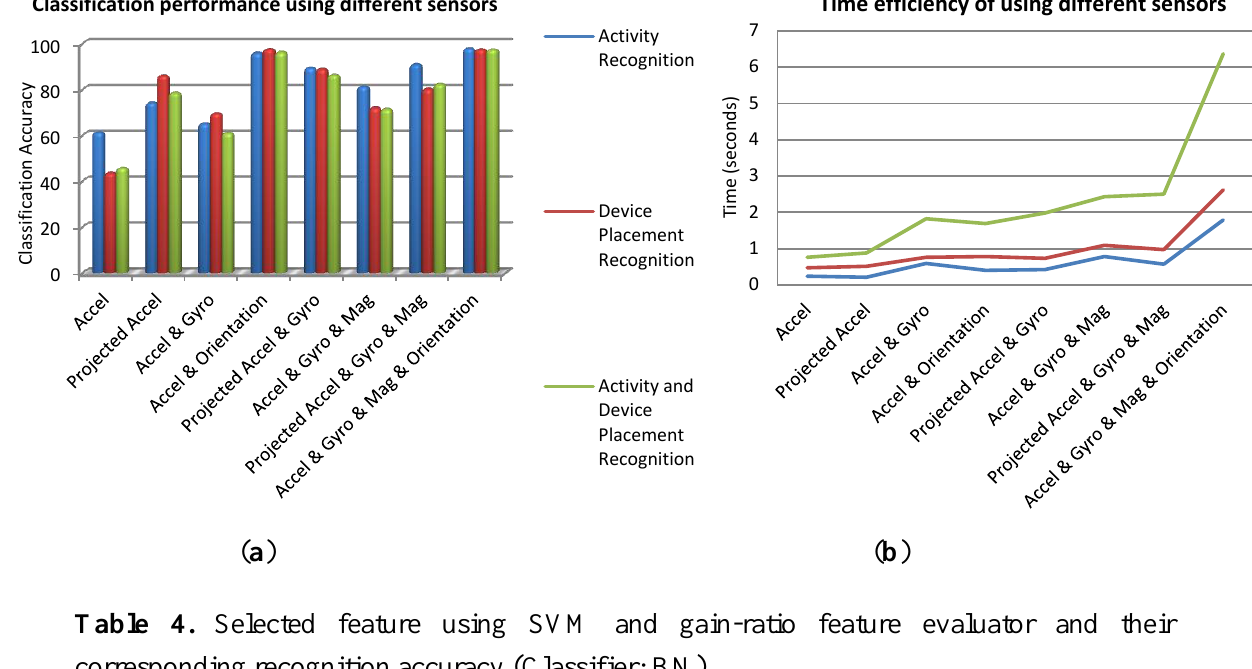
Figure 4. Results of contexts recognition using BN classifier and all the seven features: